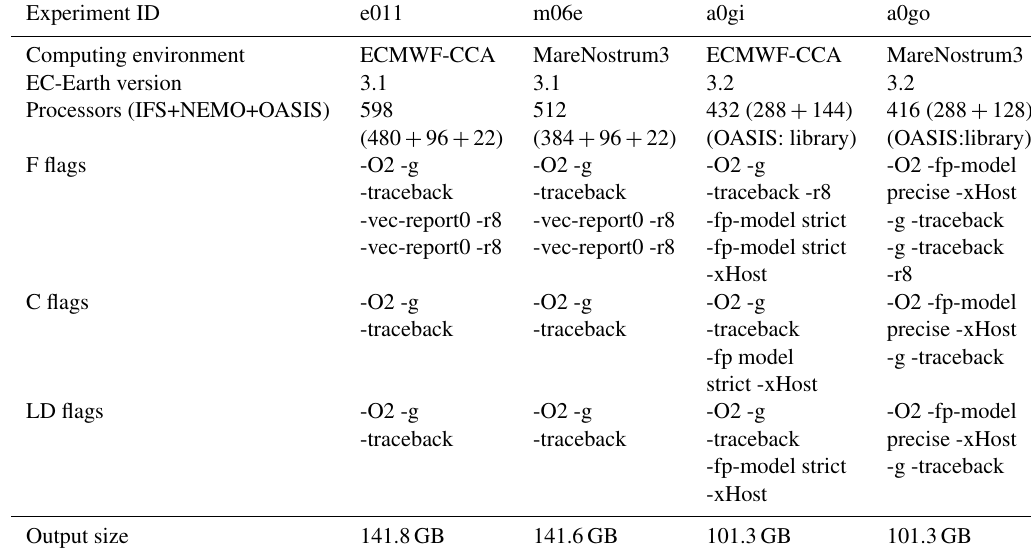
Table 2. The four experiments considered in this